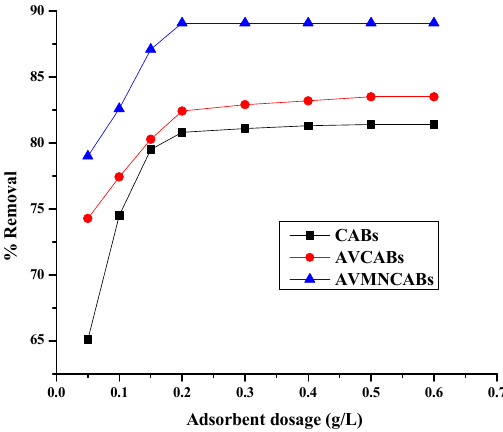
Figure 10. Variation of the removal of Cu(II) with adsorbent dose (10 μ g mL − 1 Cu(II), 1 h, 30 °C, pH 4).